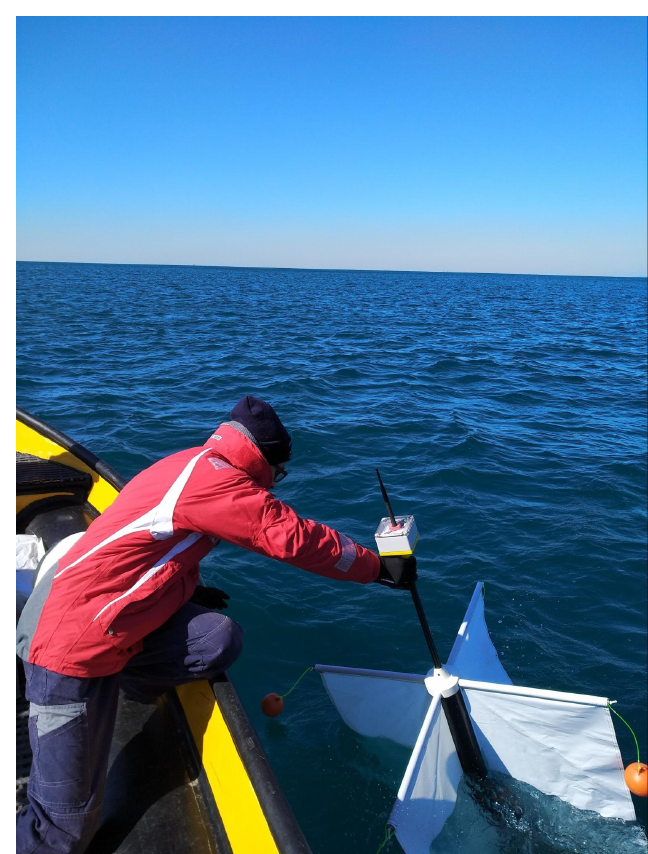
Figure 2. Drifter deployment in March 2018